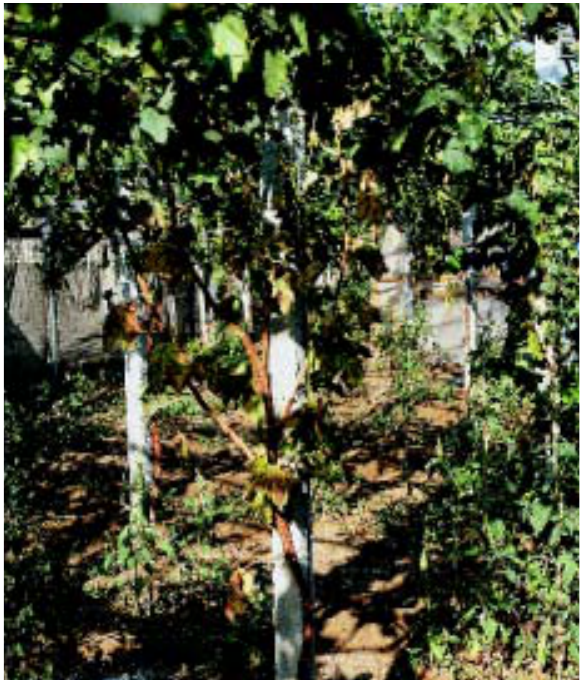
Fig. 1. Smaller leaves, chlorosis and necrosis at the margin of the leaves in declining vines heavily colonized by Phaeoacremonium chlamydosporum (cv. Victoria/775 Paulsen).